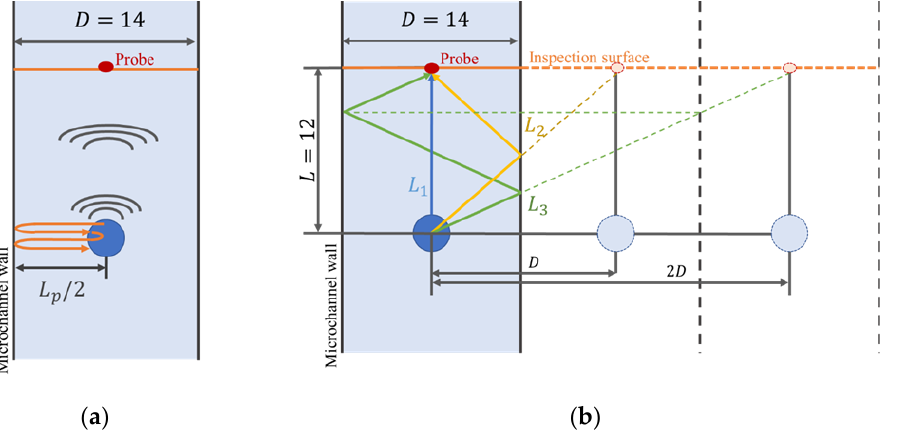
Figure 9. Schematics of the path of the pressure wave from the bubble to the pressure probe point. ( a ) Path of the pressure wave through the wave reflection between the bubble and wall; ( b ) Path of the pressure wave to the pressure probe through the wave reflection at the wall.